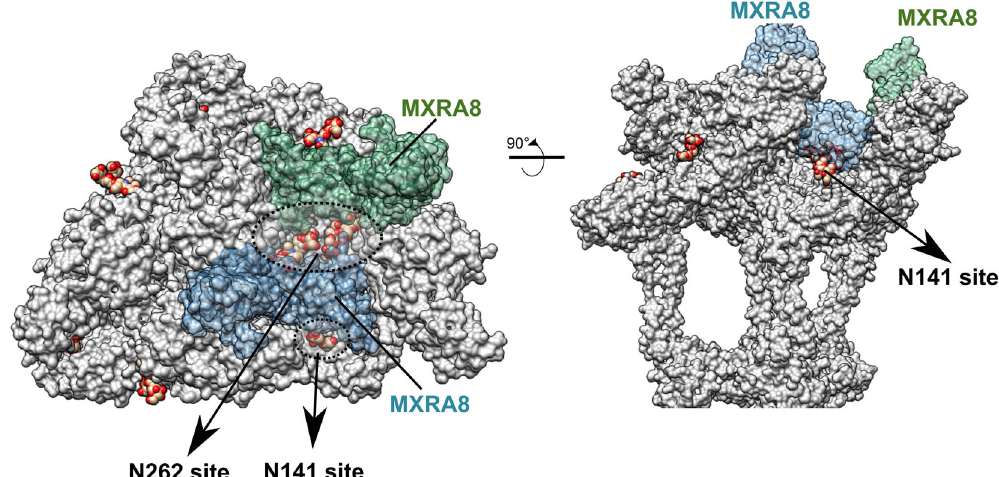
Fig. 5 MAYV glycosylation sites may play a role in the interaction with the MXRA8 receptor. The E1 and E2 monomers are shown as grey surface. The MXRA8 receptor surfaces were mapped in the MAYV cryo-EM structure by superposing the cryo-EM structure of murine MXRA8 in complex with CHIKV (PDBid 6NK624). The N141 (E1) and N262 (E2) glycosylation sites are highlighted by dashed lines and pointed. Top (left) and side (right) views are shown. The N262 handshake glycosylation site is located at the center of the MXRA8 interaction site and potentially participates in the interaction with the host MXRA8